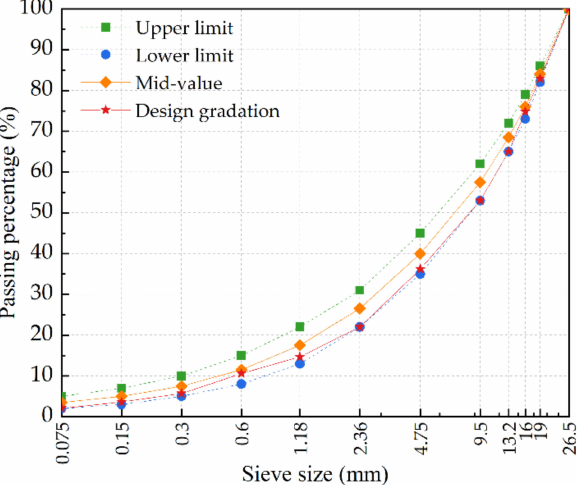
Figure 2. Aggregate gradation curve of